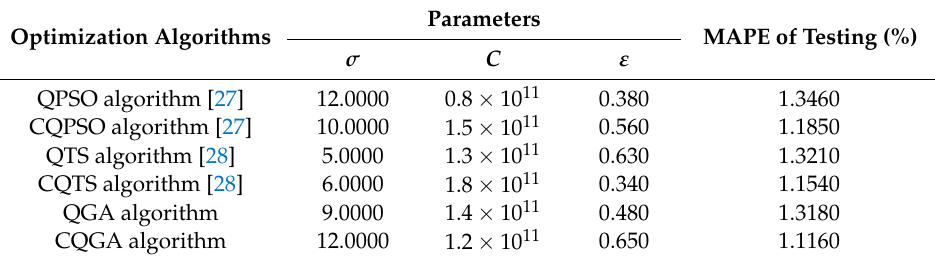
Table 5. Determined parameters of SVRCQGA and SVRQGA models (Example 2).